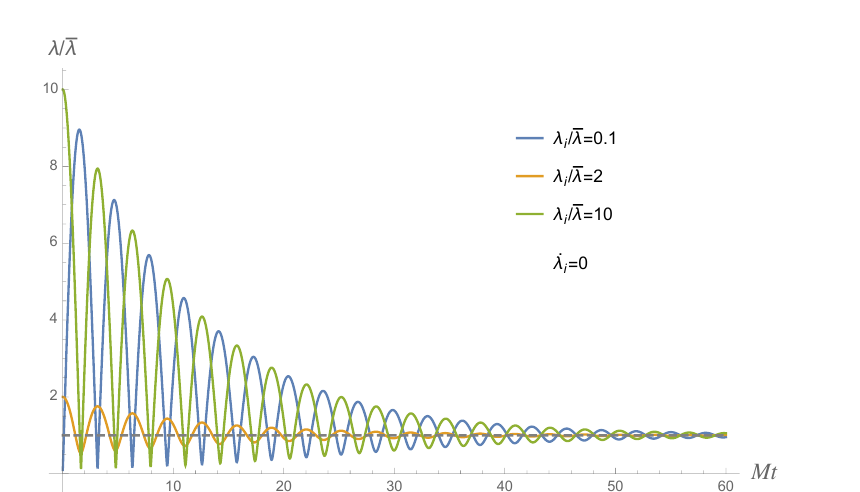
Figure 1. The amplitude λ relaxes to the minimum point ¯ λ (dashed line) of the e ff ective potential (9) within a few Hubble times, independently of the initial value. We have chosen M range shown corresponds to 3 Hubble times, and assumed the exact de Sitter space-time for simplicity. The figure is taken from Ref.